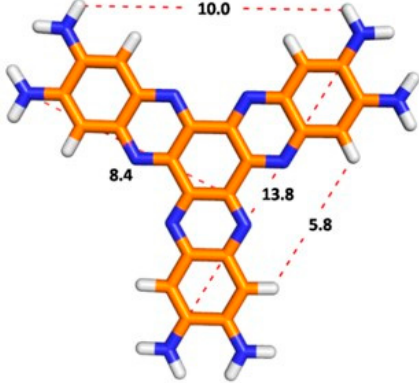
Figure 5. Optimized geometry of G1 (B3LYP/6-31g*, vacuum) and distances (Å) between atoms.